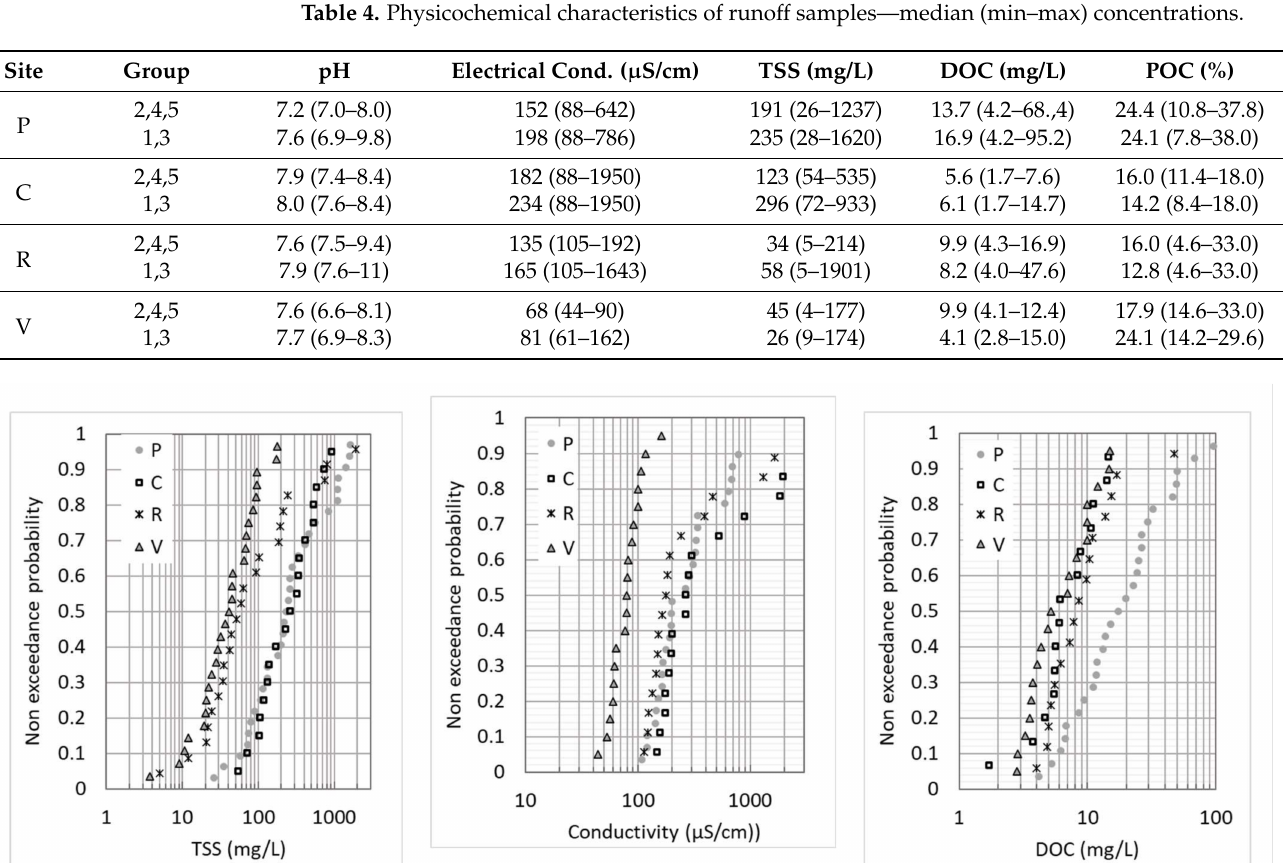
Figure 1. Non-exceedance probability distributions of EMCs for the TSS, conductivity and DOC at the four study